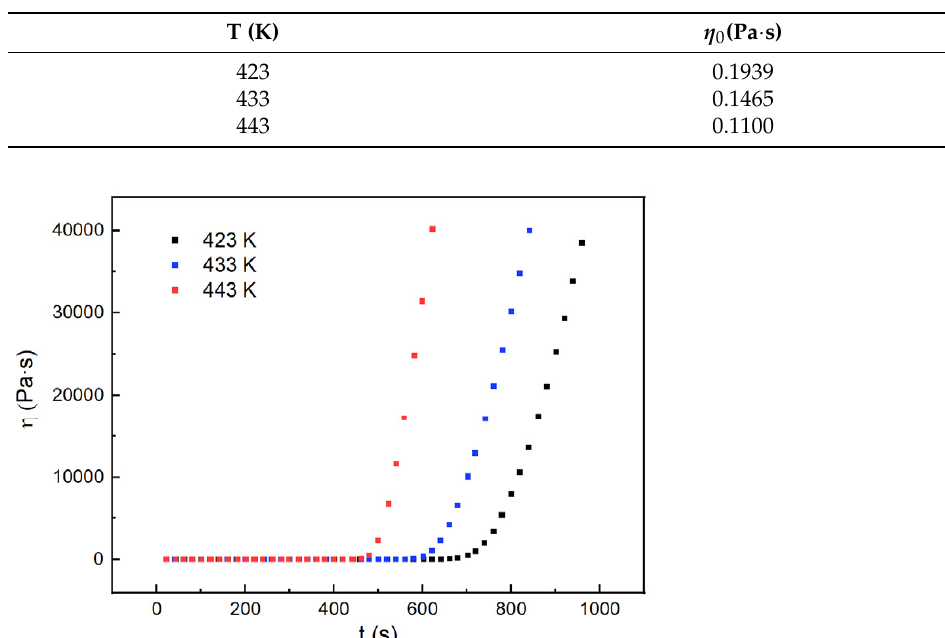
Table 4. η (cid:2868) values of the H 6 XDI/BES system at different temperatures. T ( K ) 𝛈 𝟎 ( Pa·s )